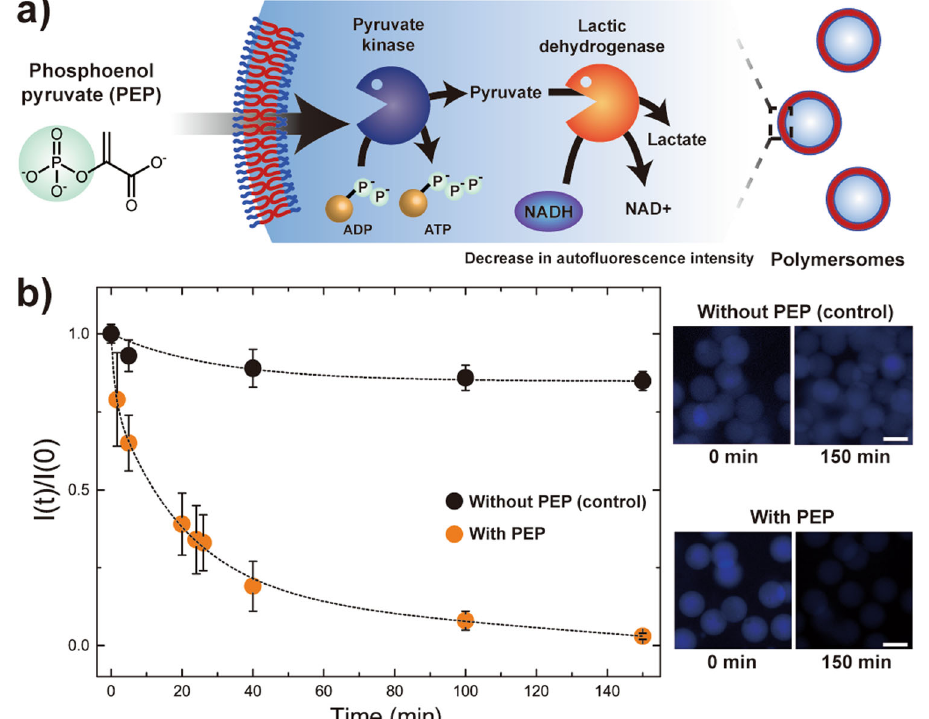
Fig.4|Signal-drivencascadeenzymaticreactioninpolymersomes.a Schematic illustration of the PEP-driven cascade enzymatic reaction in polymersomes by incorporationofbothpyruvatekinase(PyK)andlacticdehydrogenase(LDH). b Plot